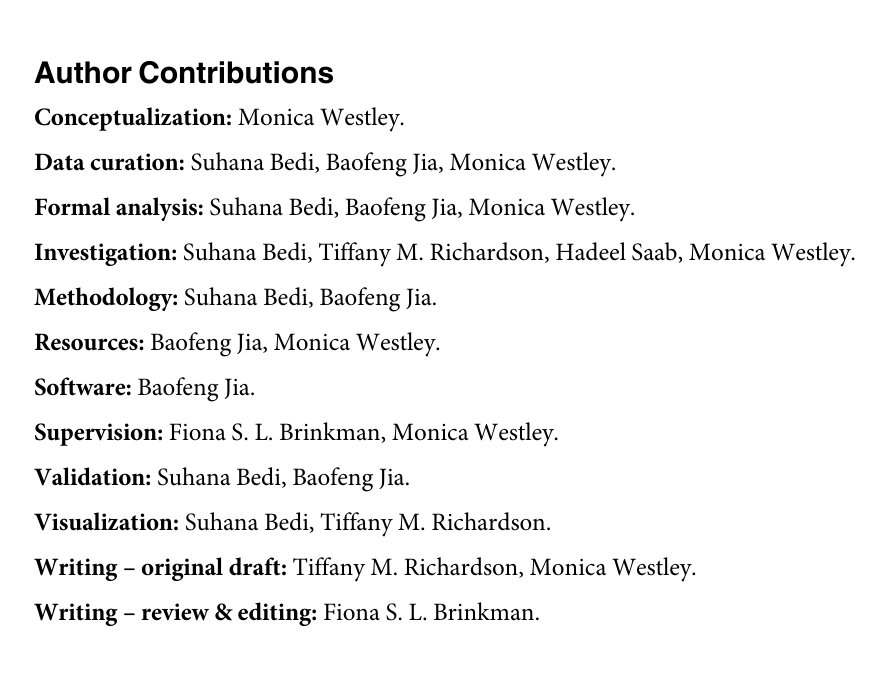
S1 Fig. Multiple sequence alignment of twenty bacterial GAD proteins and three animal GAD65 proteins highlights conserved residues. Across a diverse number of bacterial species and 3 animal species, 12 amino acids were found to be 100% conserved. Amino acids 1–110 are likely signal peptides required for eukaryotic protein translation and cellular transport not needed in bacteria. H275 and K276 are key residues required for PDD binding and are con- served in human GAD65 and bacterial